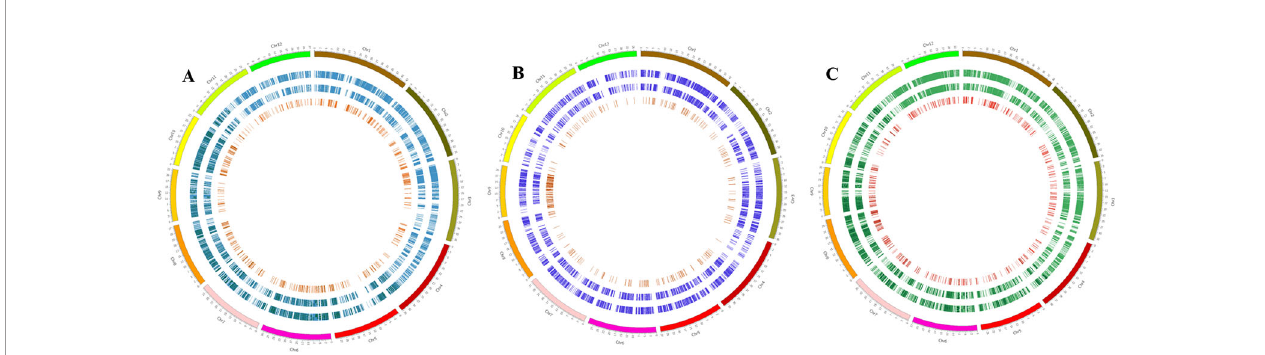
FIGURE 2 | Circos plots showing the distribution pattern of SNPs and InDels in the genic regions of three Basmati varieties. (A – C) Distribution of SNPs and InDels in Basmati varieties in comparison with Nipponbare (A) , Kasalath (B) , and Zhenshan 97 (C) reference genomes. The outermost circle represents 12 chromosomes of the rice genome. The second circle from the outside represents common SNPs. The third circle from the outside represents functional SNPs. The innermost circle with red bars shows the distribution of InDels ranging in size from 5 to